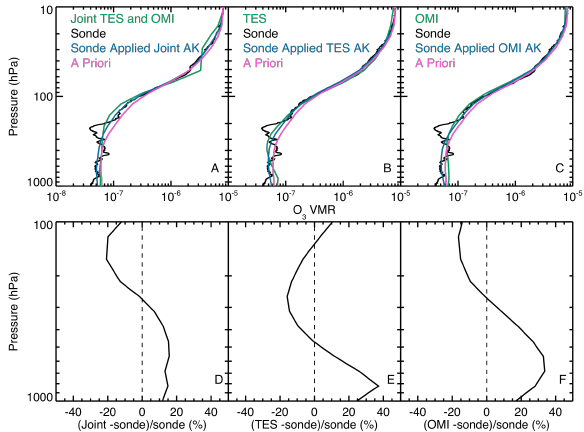
Figure 5 . Percentage differences between coincident Aura measurements and ozonesonde measurements in the troposphere: joint TES and OMI (black plus), TES only (green diamond), OMI only (purple triangle). The joint TES and OMI retrievals used the constraint matrix created from the MOZART3 ozone climatological covariance. The TES only and OMI only used an altitude-dependent Tikhonov constraint matrix. A priori ozone profile varies for each scene. Each scene listed in Table 2 is identified by the measurement index in the X axis. The averaging kernels of Aura measurements were applied to the ozonesonde measurements.